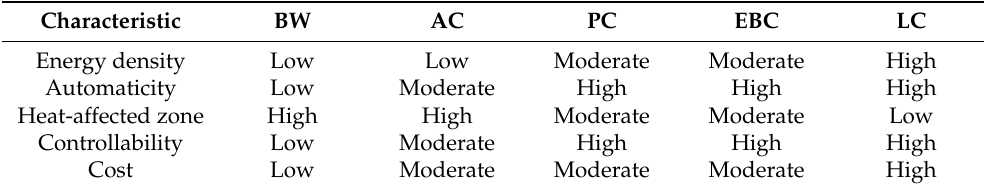
Figure 1. Microhardness enhancement ratio of cladding layers on a TC4 substrate fabricated by different methods and deepen color indicates the methods with hgih energy density. (BW: buttering welding; AC: arc cladding; PC: plasma cladding; EBC: electron beam cladding; LC: laser cladding). Table 1. The characteristics of the different methods.